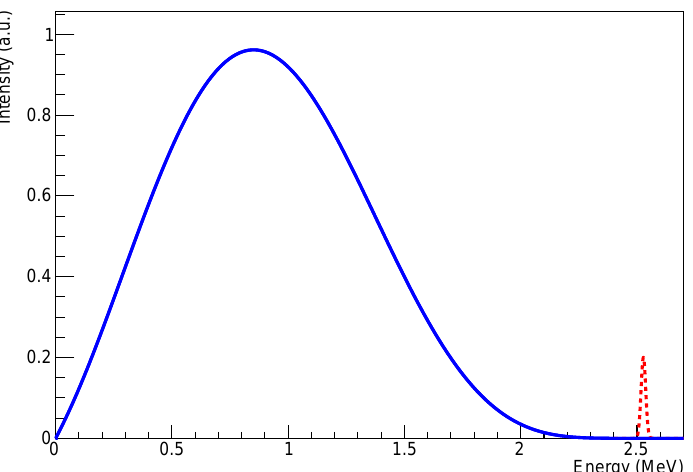
Figure 1. Schematic view of the combined energy spectrum of emitted electrons in 130 Te 2 νββ ( blue solid ) [22] and 0 νββ ( red dashed ) decay. The latter is modeled as a Gaussian of 10 keV standard deviation centered at Q ββ . The relative amplitude of the two spectra is